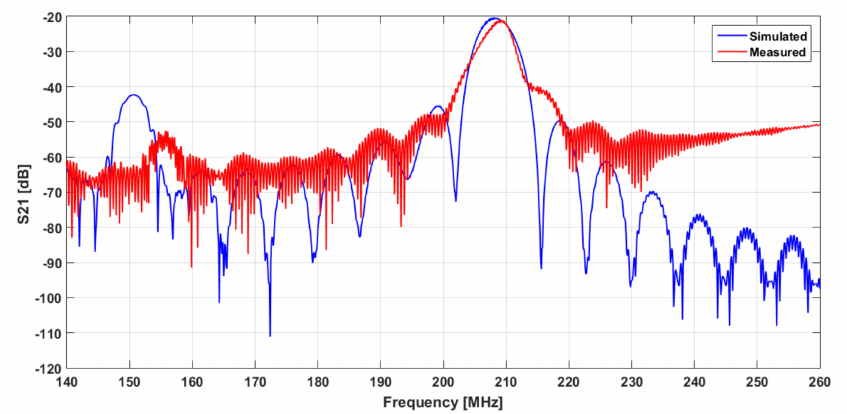
Figure 9. Simulated (2D model COMSOL, configuration: 30 pairs of double fingers + metallized sensitive area of 8 mm length) and measured S21 spectra of SAW delay line.